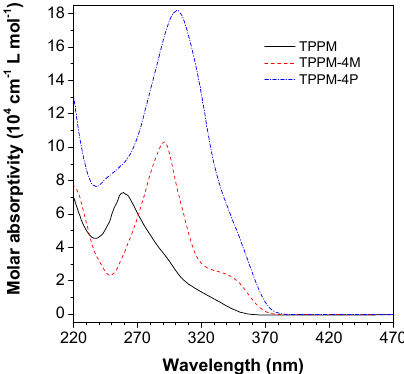
Figure 1. UV-vis absorption of TPPM and its derivatives in THF.